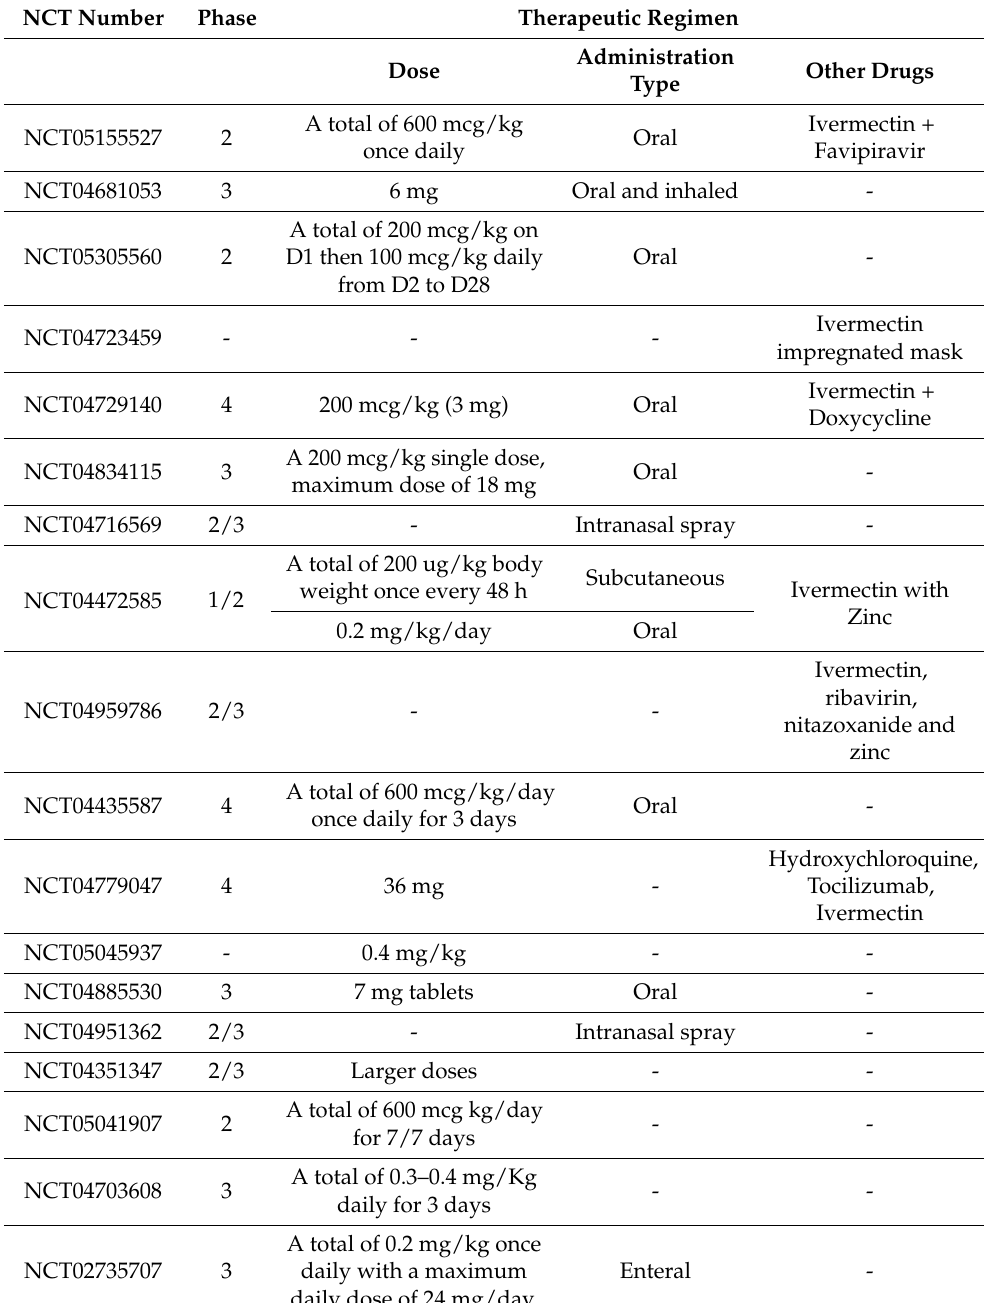
Table 6. Clinical trials using ivermectin for the treatment of COVID-19. Data was collected from clinicaltrials.gov on 28 November 2022. Inclusion criteria: Recruiting, adult population, from 1 Jan- uary 2022 to 31 December